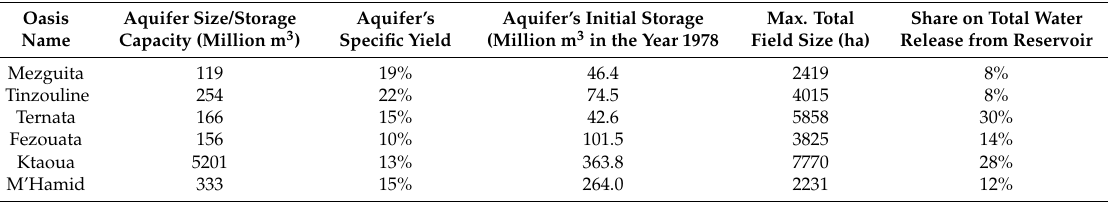
Table 1. Properties of the six oases aquifers, initial aquifer storages in 1978, the maximum total field size, and the share of each oasis on the water release from the reservoir